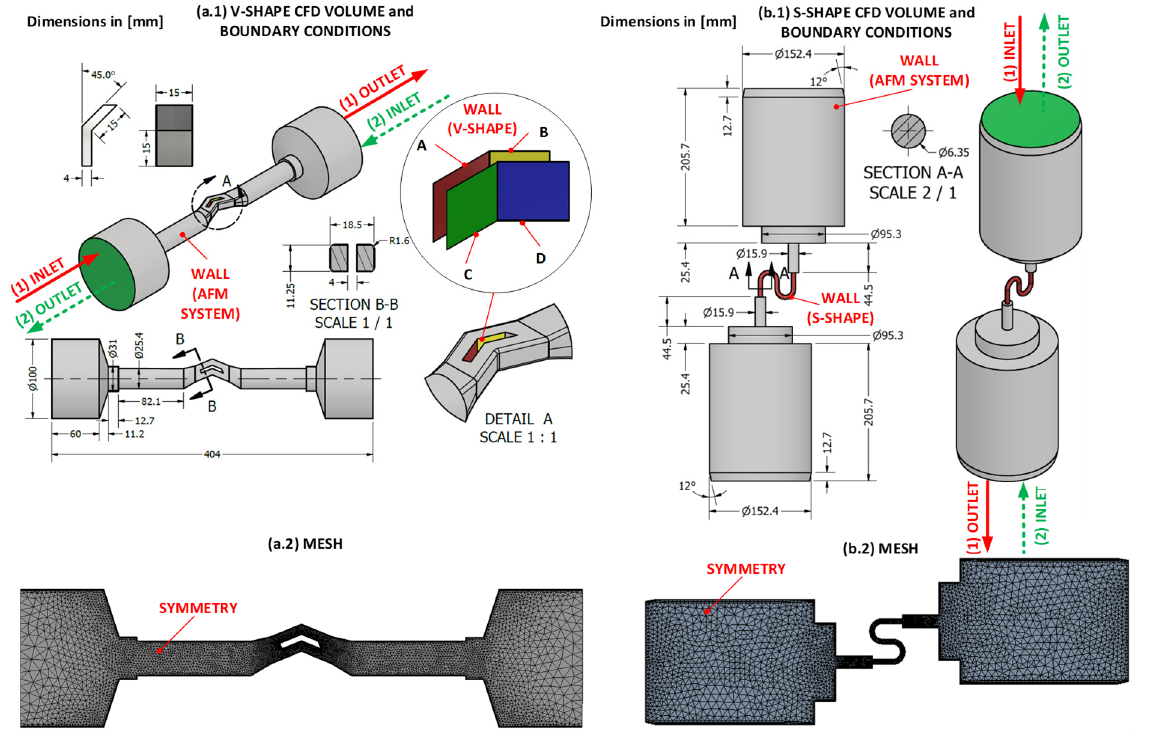
Figure 9. CFD simulation setups: ( a ) V-shape; ( b ) S-shape.